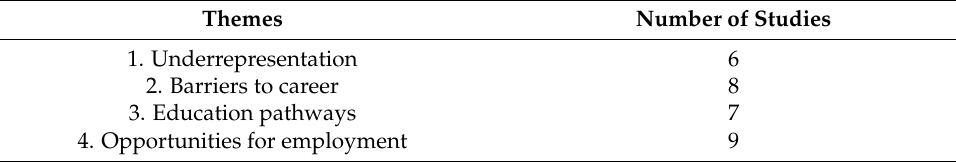
Table 6. Themes related to women in the Australian construction